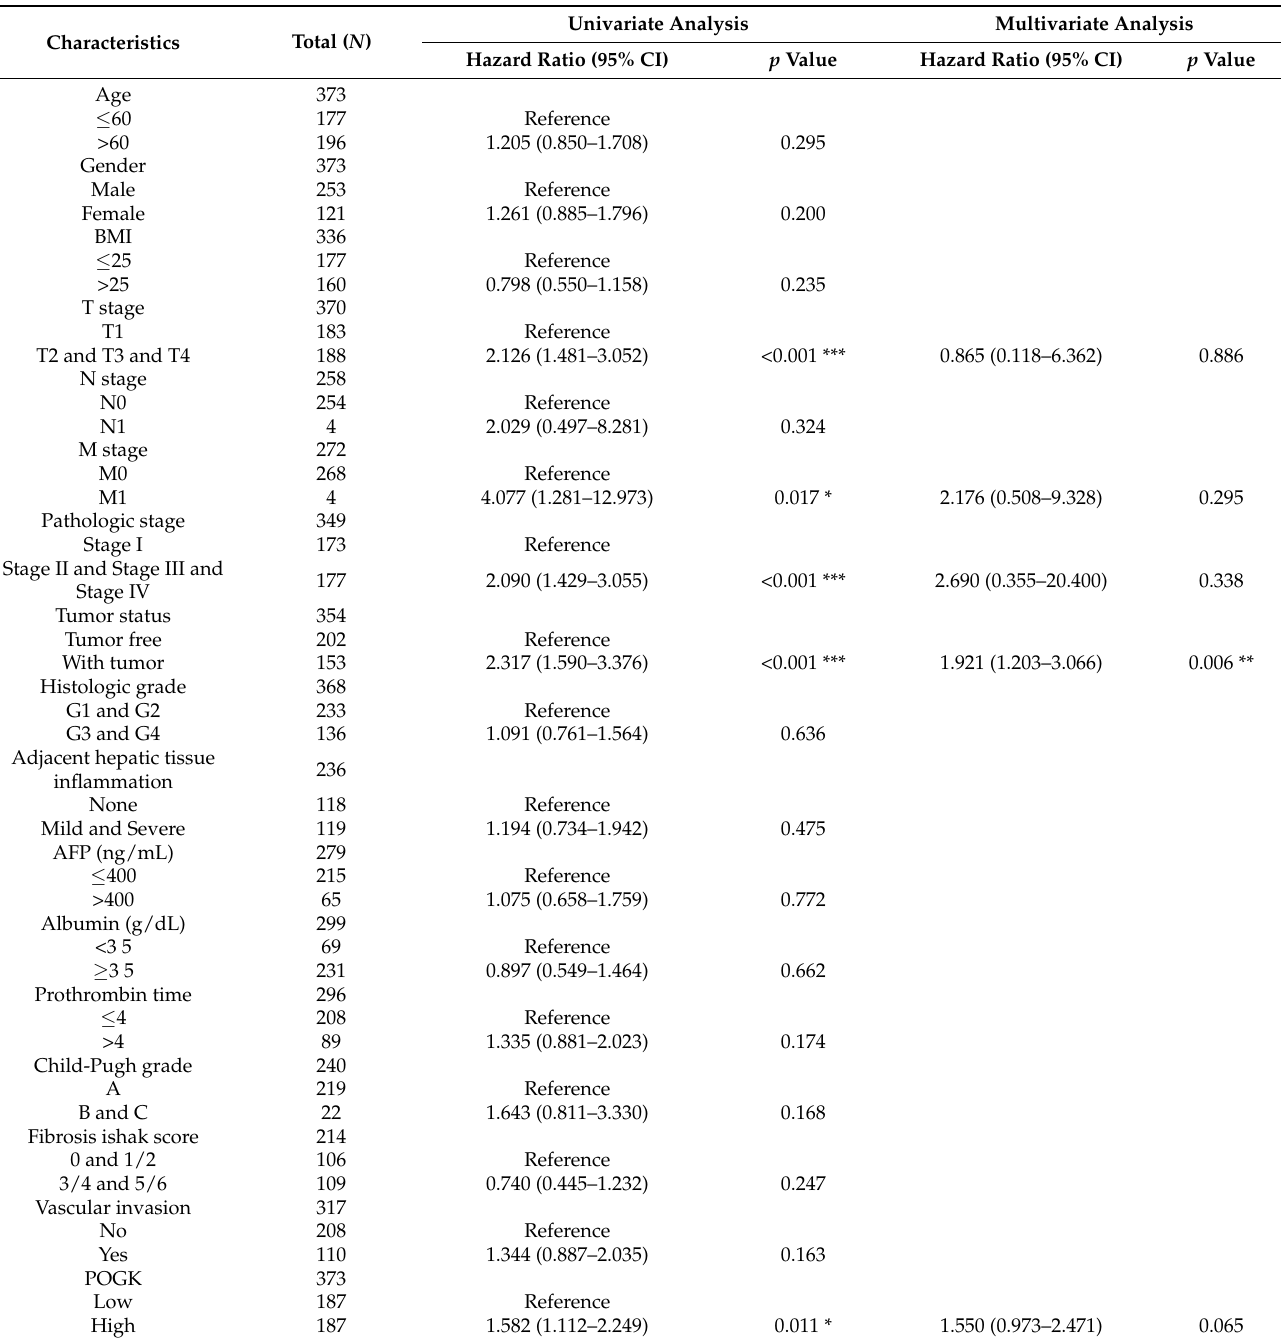
Table 3. Cox regression analysis for POGK gene